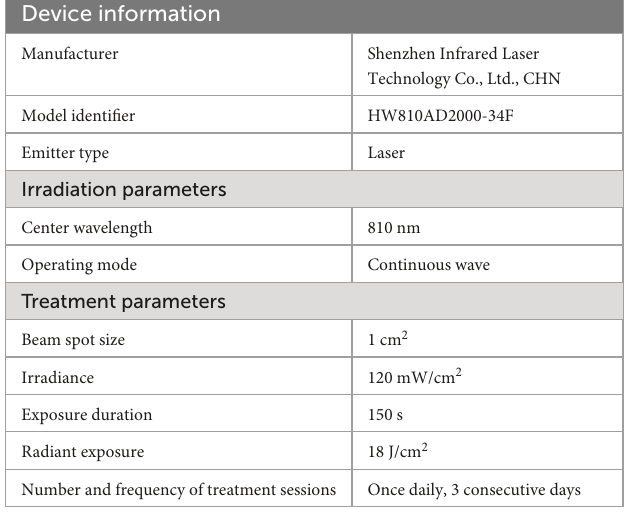
TABLE 1 Transcranial near-infrared laser